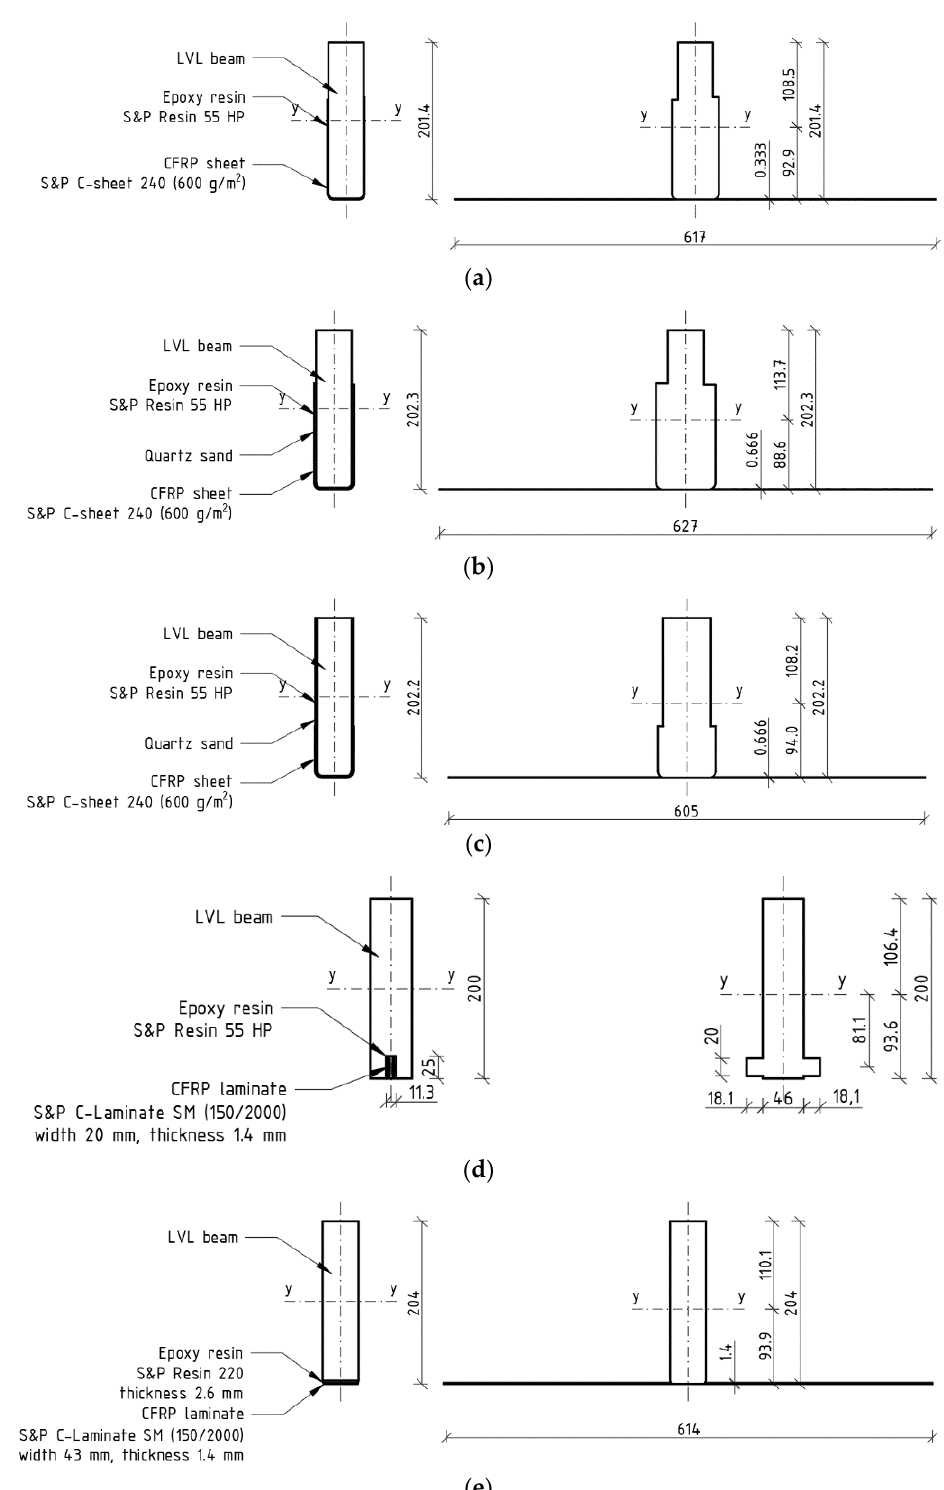
Figure 3. Transformed cross-section of reinforced beams: ( a ) beam reinforced with one layer of CFRP sheet (B series); ( b ) beam reinforced with two layers of CFRP sheet bonded one on another (C series); ( c ) beam reinforced with two layers of CFRP sheet (D series); ( d ) beam reinforced with two CFRP laminate inserts bonded into pre-drilled grooves (E series); ( e ) beam reinforced with CFRP laminate bonded to bottom side (F series).